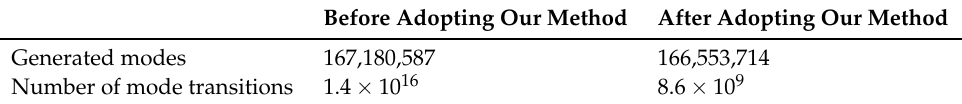
Table 1. Comparison among the various parameters obtained by Example 1. Before Adopting Our Method After Adopting Our